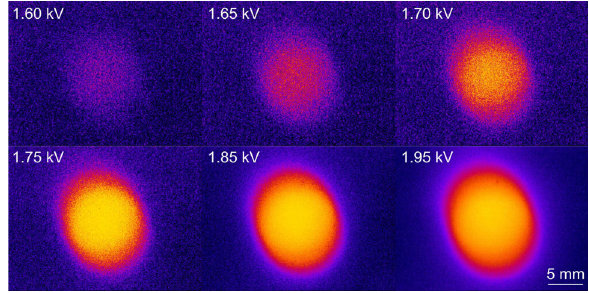
FIG. 8. Influence of the MCP gain on the image quality. See text for details.